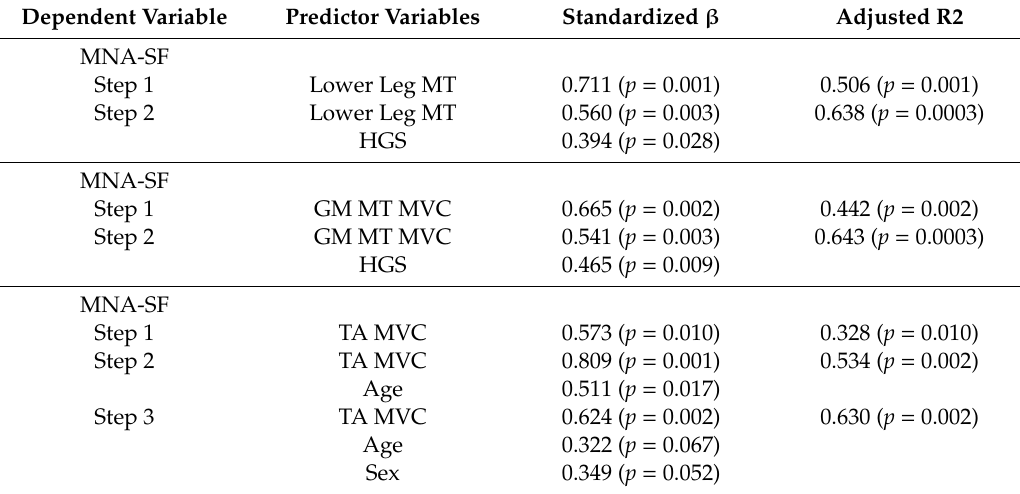
Table 5. Multiple Regression